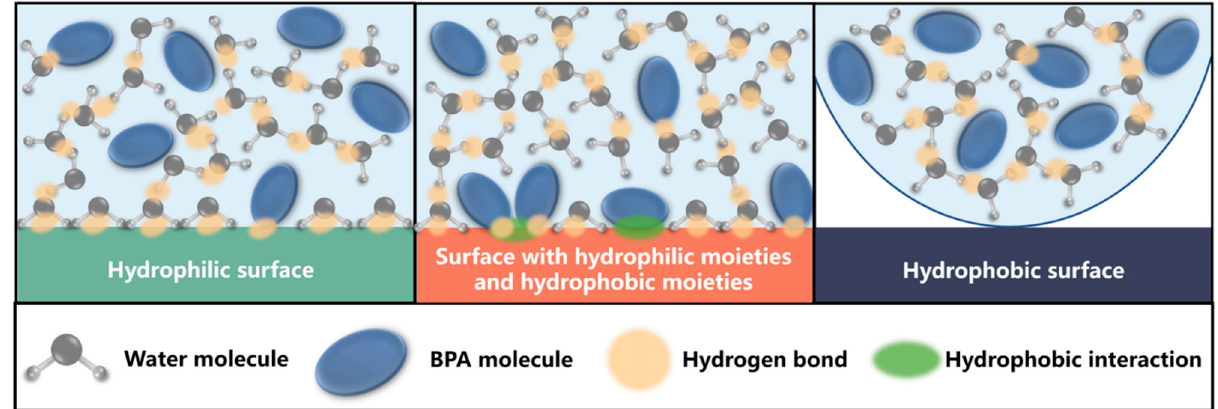
Figure 10. The interaction mechanism between BPA and